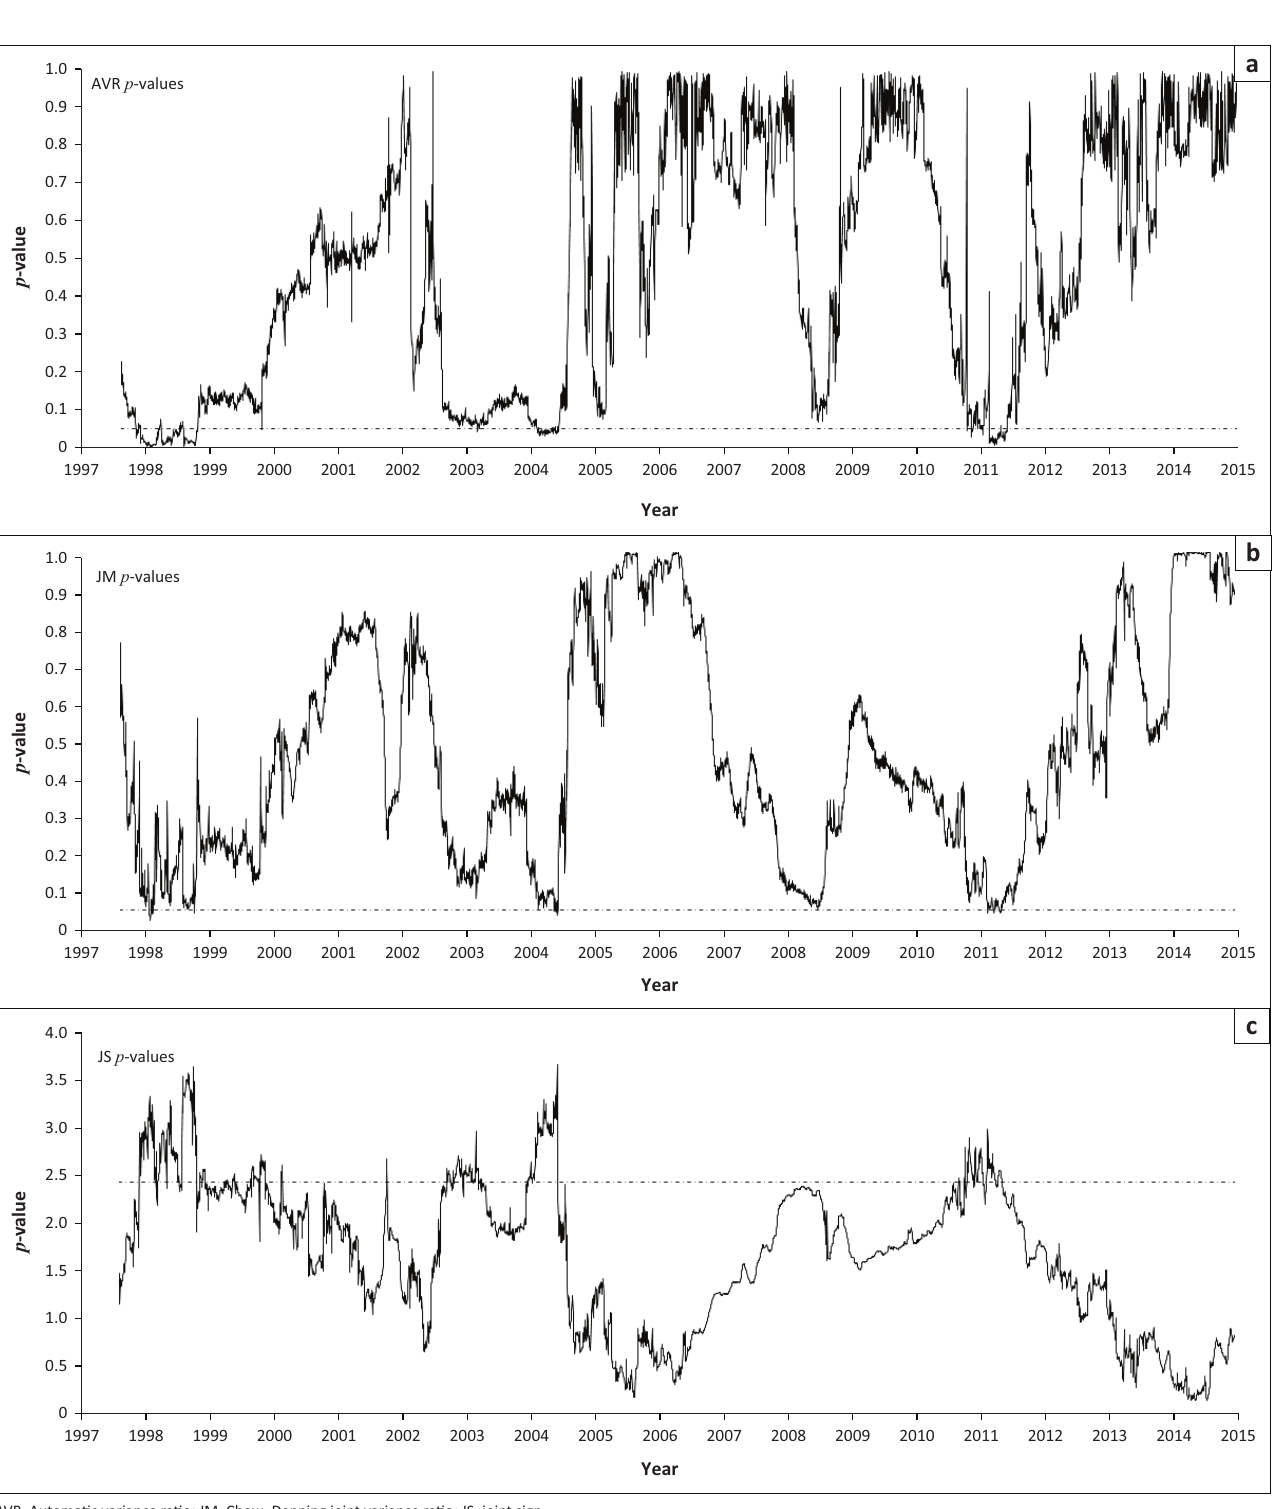
FIGURE 3: J150 – Gold mining index: (a) AVR p -values, (b) JM p -values, (c) JS p